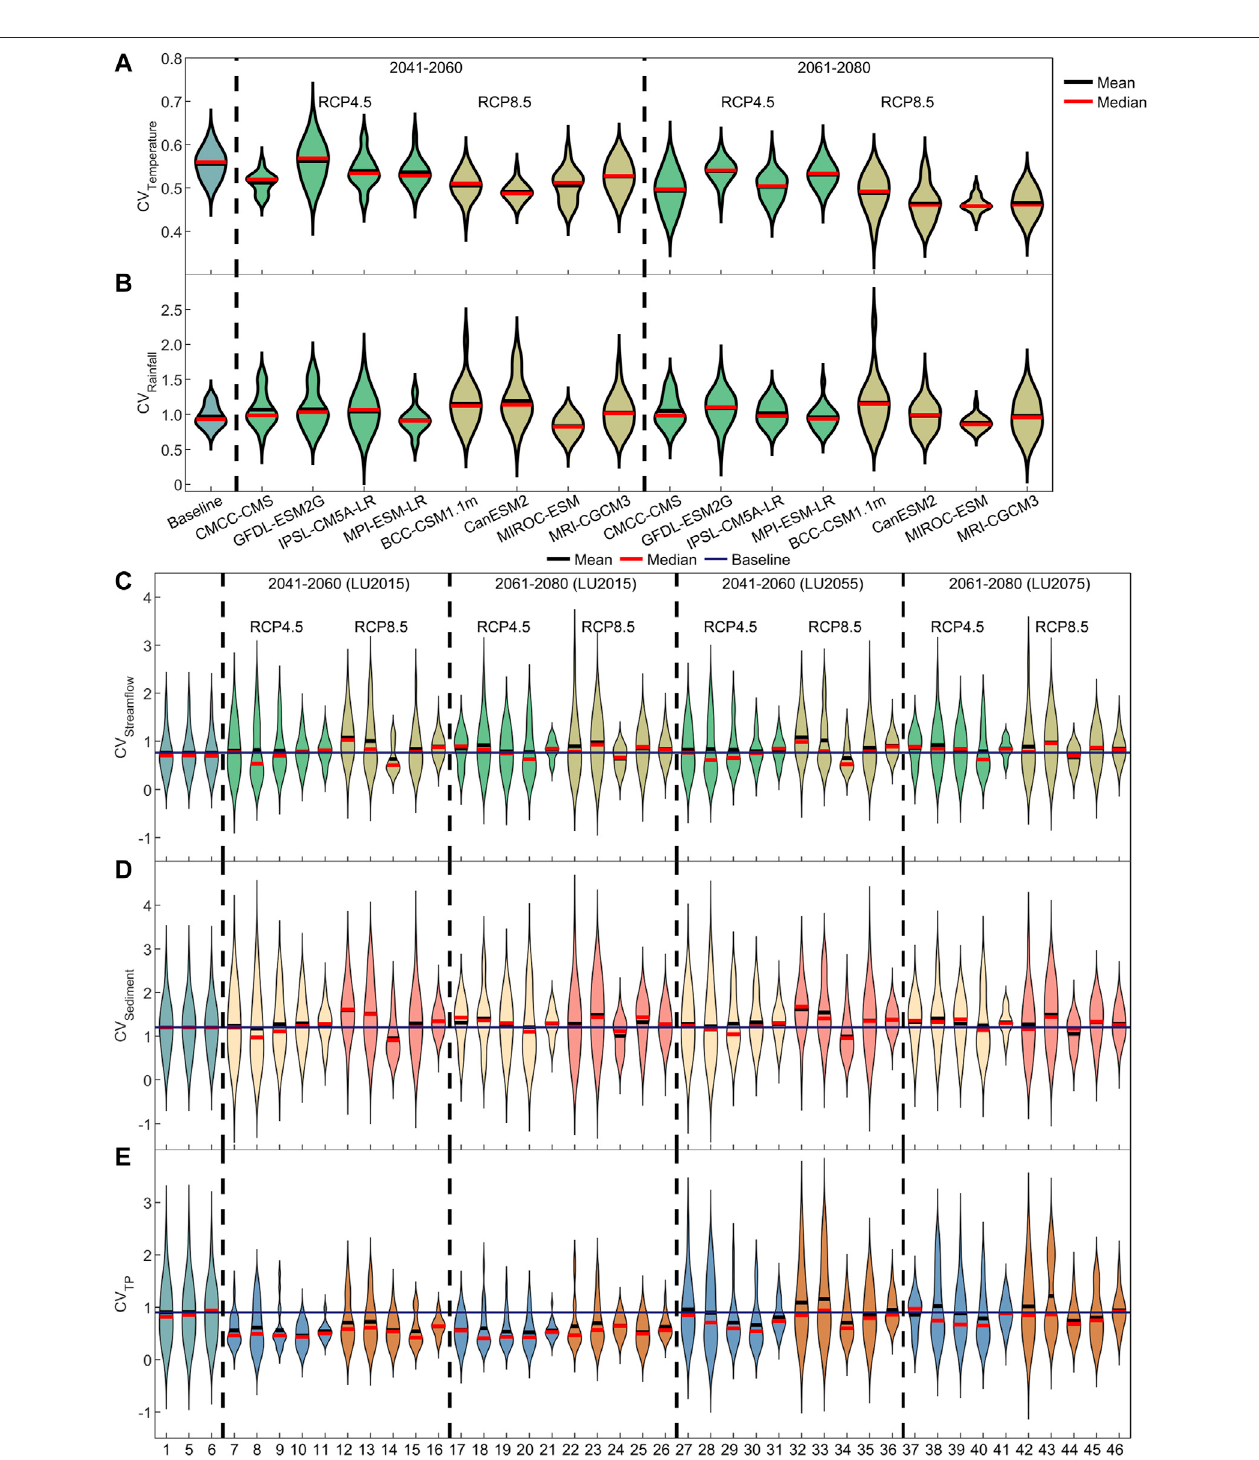
FIGURE6 | Theindividual, combined, and synergetic impact ofland-use change and climate change on thepercentage change ofmulti-model ensemble average annual stream fl ow, sediment, and TP loads compared to the baseline period (2000 – 2019).